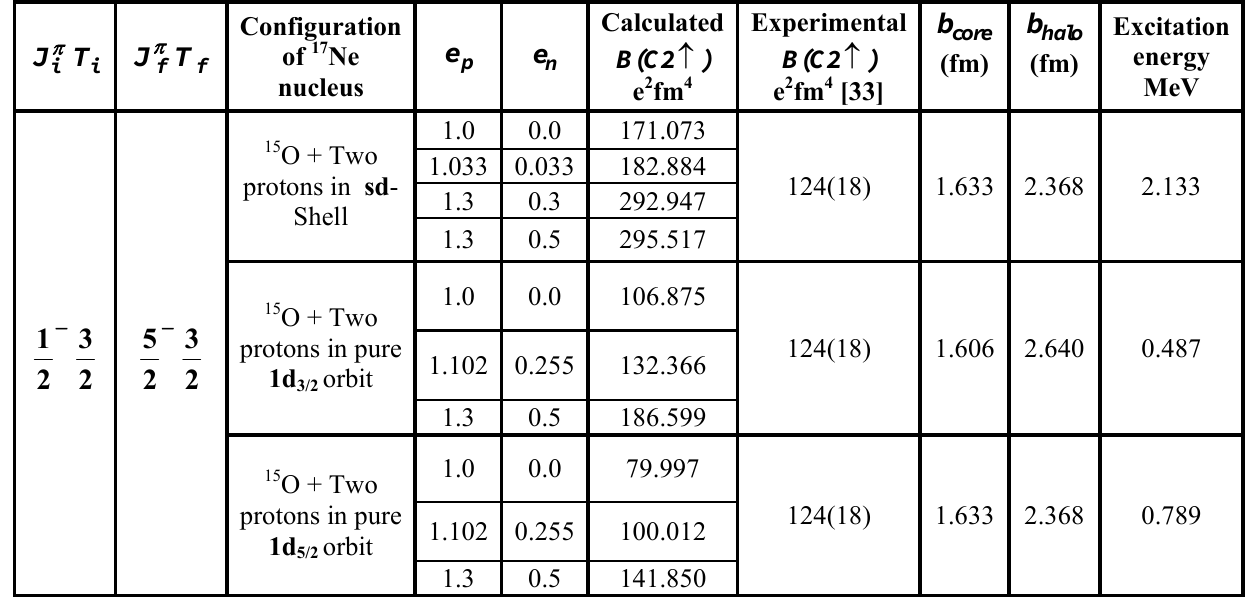
Table 2: The calculated and experimental electric transition strengths of